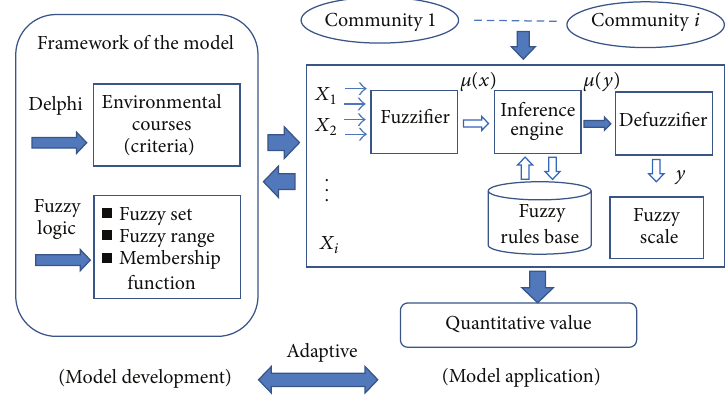
Figure 1: The framework of the evaluation